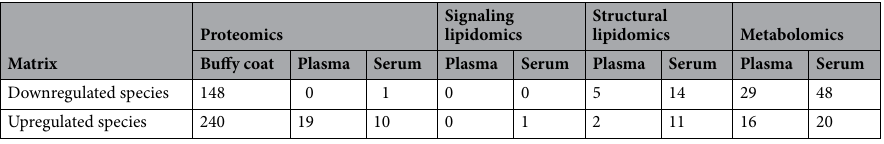
Table 1. Differentially expressed species due to hemolysis